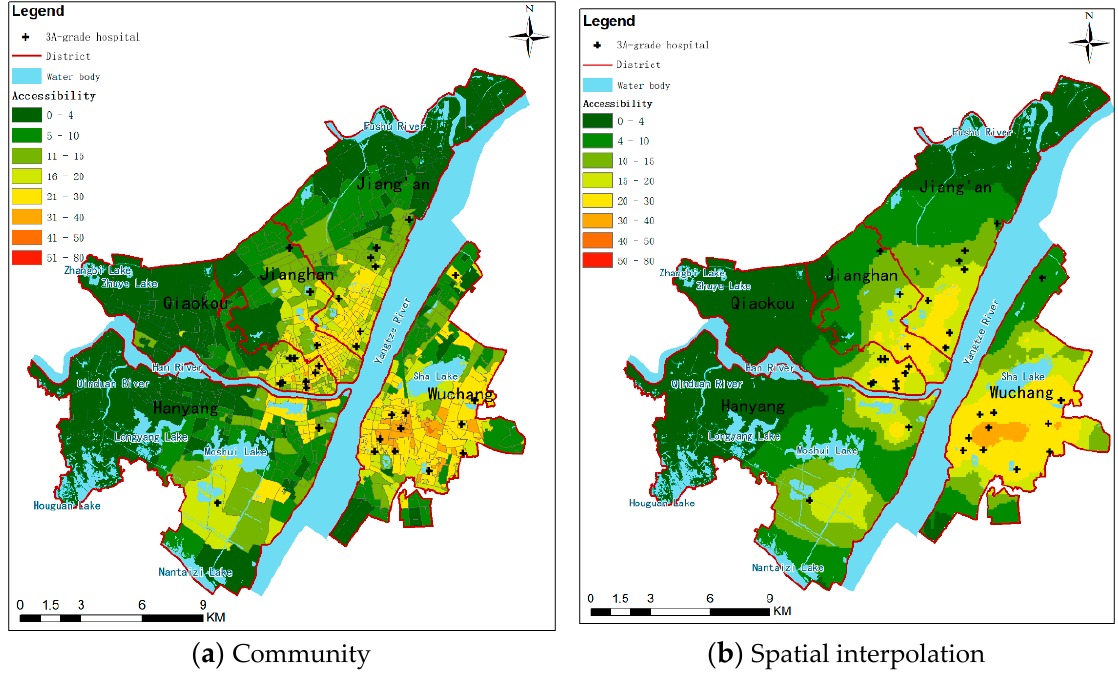
Figure 3. Accessibility of medical facilities before improvement at 2:00 a.m. ( d t = 15min).